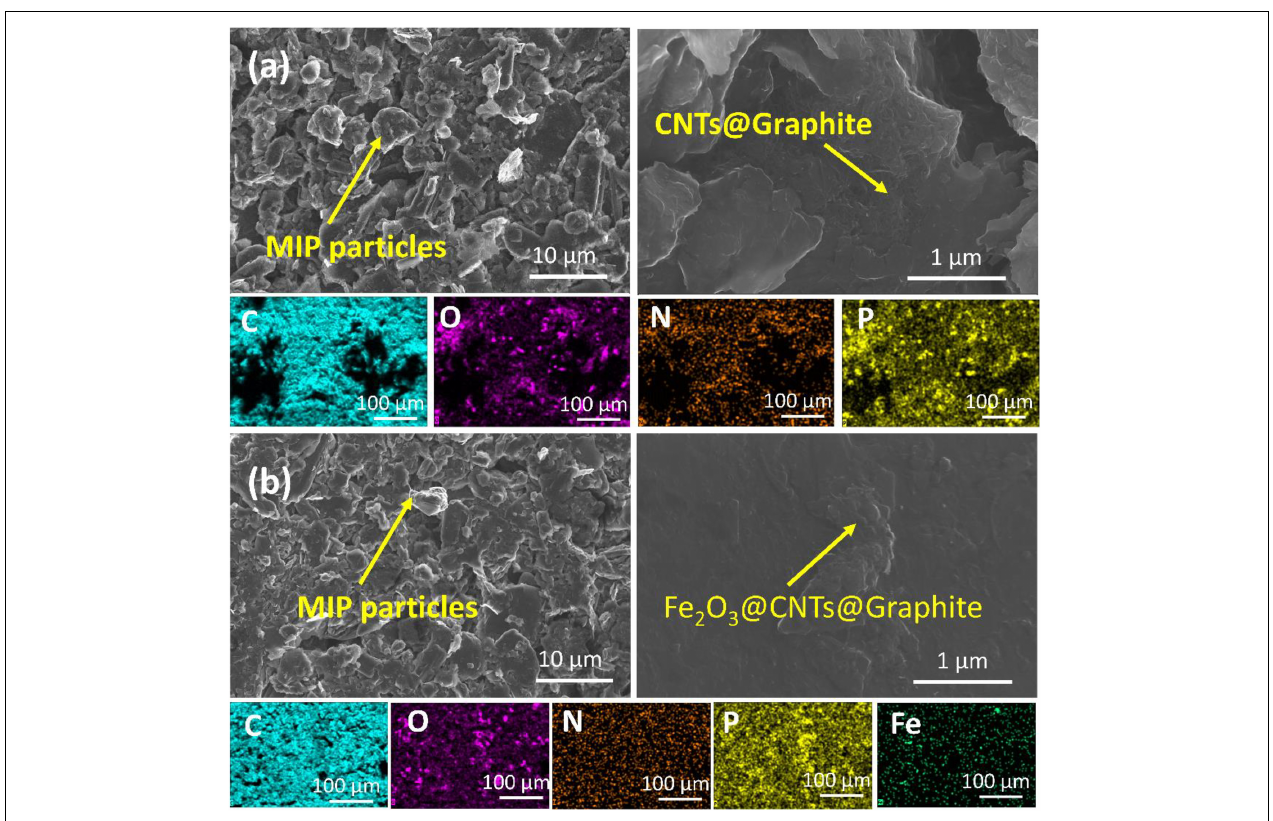
FIGURE 8 | SEM images of (a) sensor 4 and (b) sensor 5 including the elemental distribution mapping in the carbon paste matrix below each.